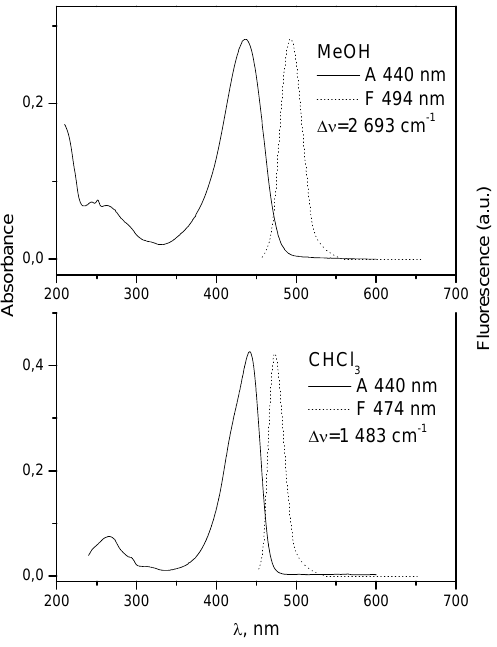
Figure 2. Absorption and fluorescence spectra of 7 in chloroform and methanol at 10 − 5 mol dm − 3 .